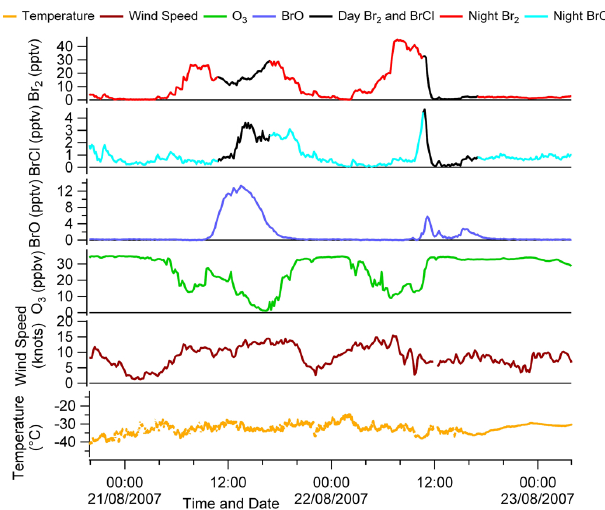
Fig. 9. Wind speed, temperature, surface O 3 and CIMS Br 2 , BrCl and BrO measurements from Halley on 21 and 22 August